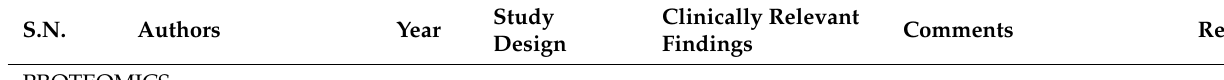
Table 4. A compilation of the literature underlining role of precision medicine in heart